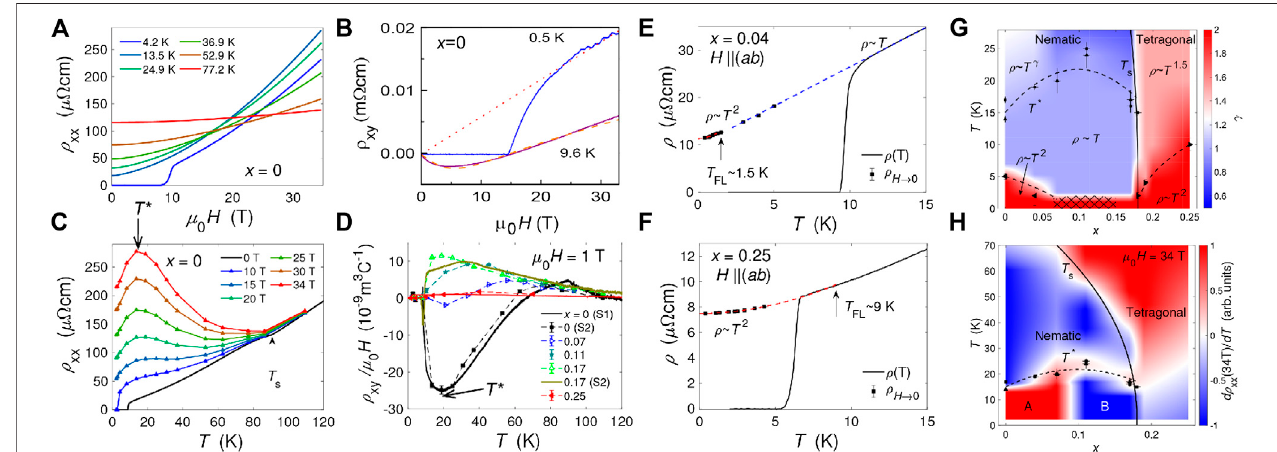
FIGURE 7 | Magnetotransport behaviour of FeSe 1 − x S x . (A) Longitudinal magnetoresistance, ρ xx and (B) Hall component, ρ xy of FeSe at different fi xed temperatures, after Refs. 28, 40. The dotted and dashed lines are fi ts to two-band and three-band models, detailed in [40]. (C) The temperature dependence of magnetoresistance in fi xed magnetic fi eld indicating signi fi cant effects inside the nematic phase. Below T* there is an unusual drop in magnetoresistance of FeSe suggesting potential changes in scattering and/or the electronic structure. (D) Hall effect coef fi cient in low magnetic fi elds ( B (cid:2) μ 0 H ≤ 1T), indicating a sign change and the dominance of different highly mobile carriers across the nematicphase. The low-temperature linear resistivity for x (cid:2) 0.04 (E) and x (cid:2) 0.25 (F) . The solid lines are the zero- fi eldresistivitydata. Solidcircles representthe zero- fi eld extrapolated values fromhigh fi eld longitudinal resistancemeasurements when B ||( ab ) plane [28].The dashed linesrepresent fi tstoaFermi-liquidbehaviourfoundbelow T FL ,asindicatedbyarrows. (G) Thelow-temperatureresistivityexponentbelow T* ,extrapolated from high magnetic fi elds, indicating the unusual transport behaviour of the nematic phase. (D) The colour plot of the slope of resistivity in 34T between the nematic A and B phases. Solid squares represent T s and solid triangles T c . T* indicated by stars represents the peak in magnetoresistance and the maximum in of the Hall coef fi cient R H . Solidlinesindicatethenematicandsuperconductingphaseboundariesandthedashedlinesareguidestotheeye.Allthesamplesshowclearquantumoscillationsinthe transverse magnetoresistance below 1.5 K [27], consistent with the presence of the Fermi-liquid behavior at low temperatures for all samples. These data are adapted after Ref. 28.